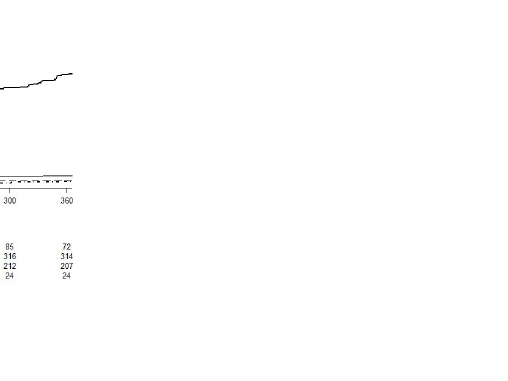
Fig 3. Overall 12-month mortality according to